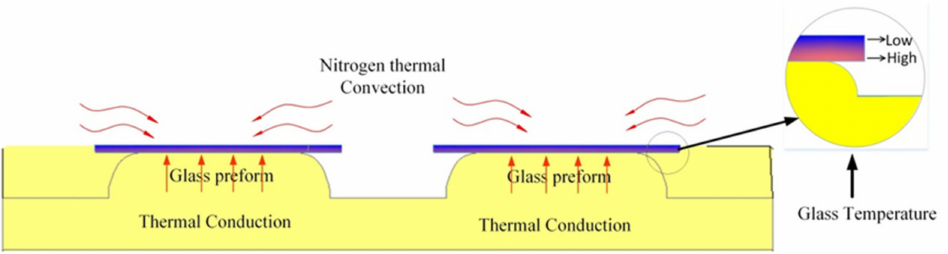
Figure 5. Schematic diagram of glass heat